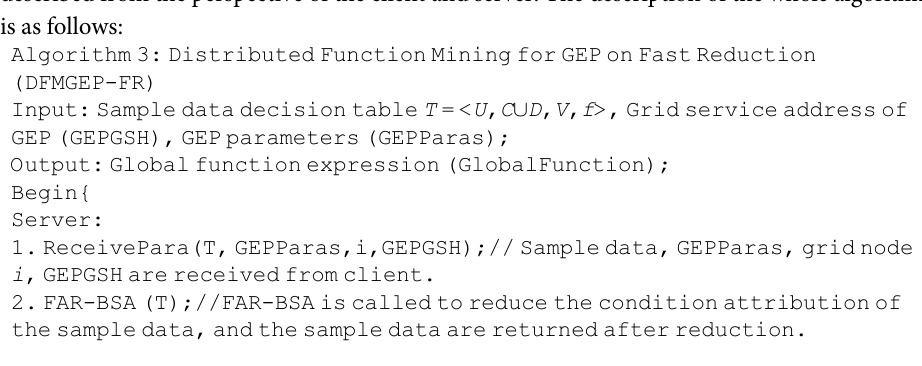
Algorithm 3: Distributed Function Mining for GEP on Fast